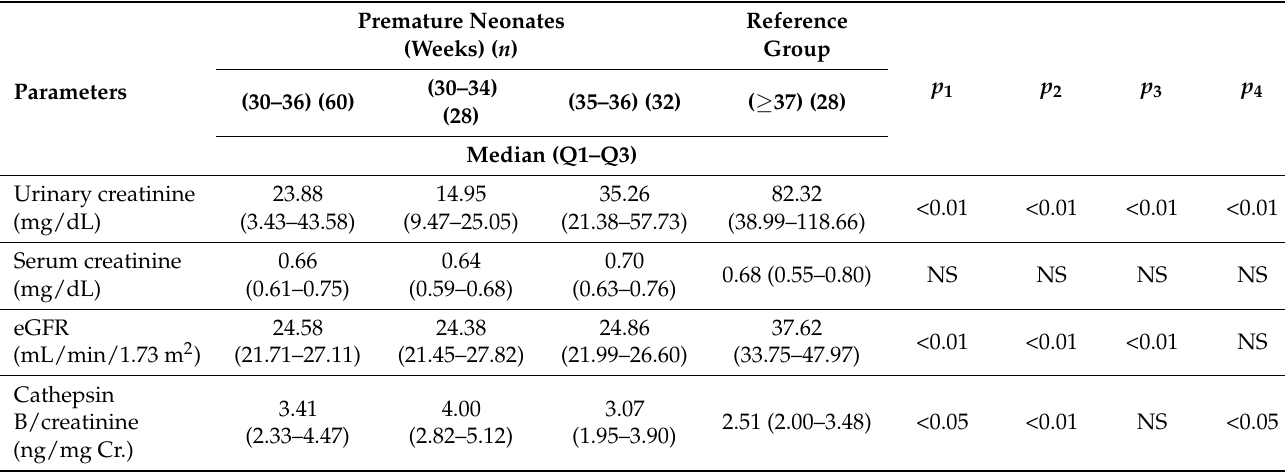
Table 3. Examined parameters in premature neonates and the reference group—median values and interquartile range